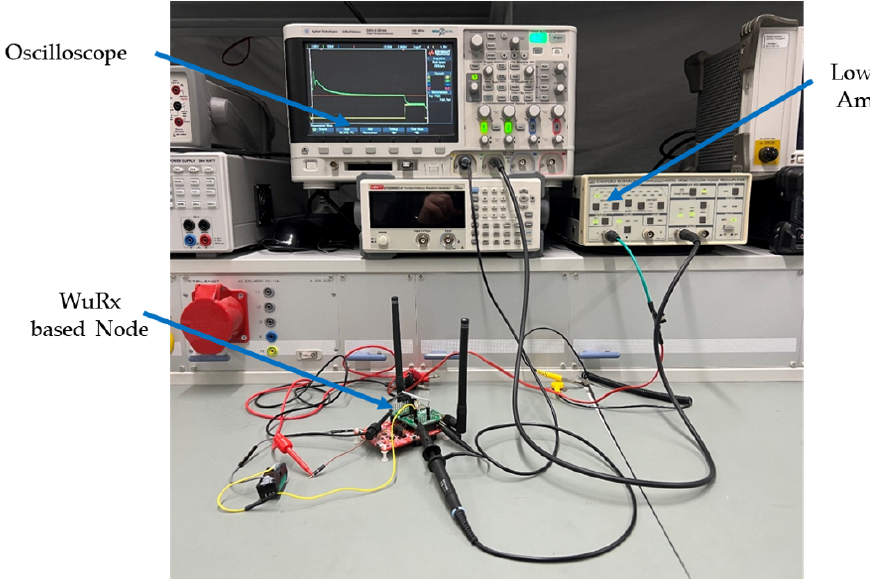
Figure 10. Set up used for